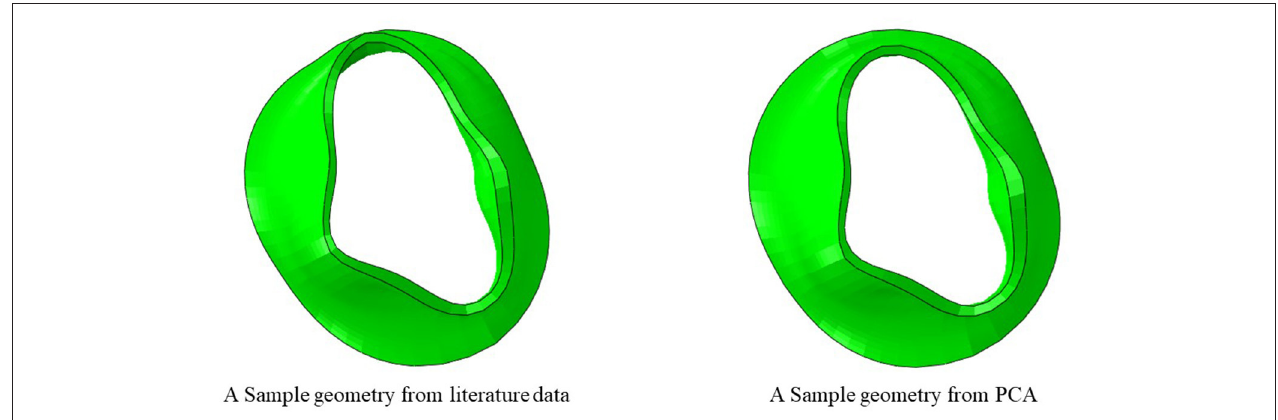
FIGURE 4 | A model created from literature data and a model created using PCA.